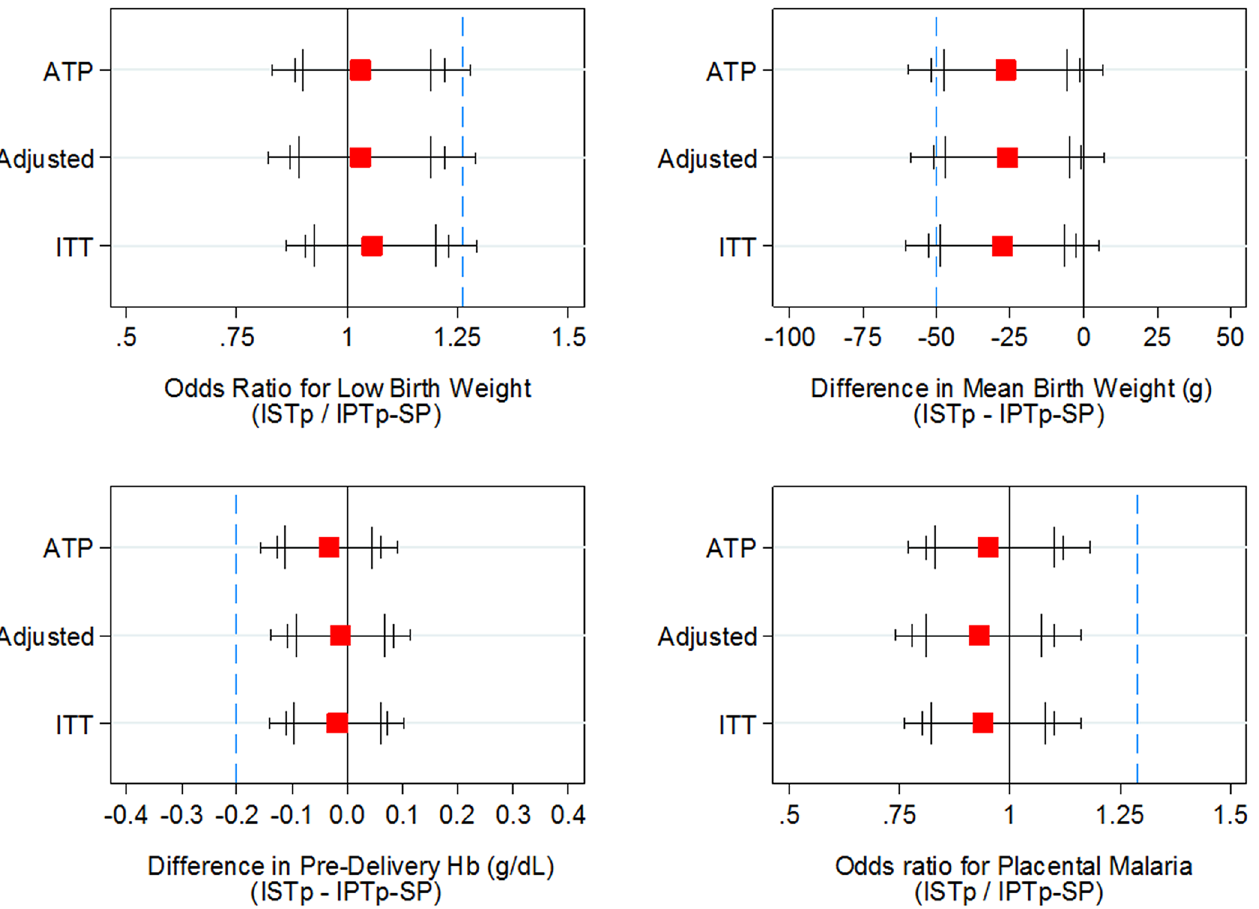
Fig 2. Non-inferiority plots for primary outcomes and mean birth weight. The figures show two-sided 90%, 95% and 99% confidence intervals (largest to smallest vertical bars, respectively), equivalent to one-sided 95%, 97.5% and 99.5% confidence intervals. The dashed blue vertical line indicates the non- inferiority margin. ATP, according to protocol population (adjusted for site); adjusted, ATP population adjusted for site, gravidity, age group, gestational age, ITN use and socio-economic status; ITT, intention to treat, (adjusted for site). Numbers included in the analyses and numeric values of the estimates are provided in the supplement (S4